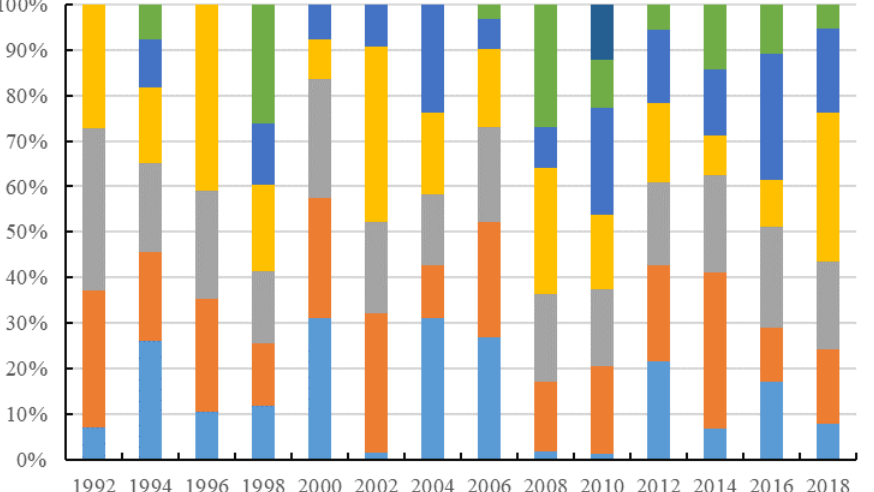
Figure 4. Ratio of the number of community members from 1992 to 2018. From 1992 to 2018, the number of communities remained stable at 4–7 (Table 1). According to the distribution proportion of the members in the communities, the size of the community is uneven. There are communities with a large number of members and clusters with a small number of members (Figure 4). Table 1. The evolution of modularity and community numbers. 1992